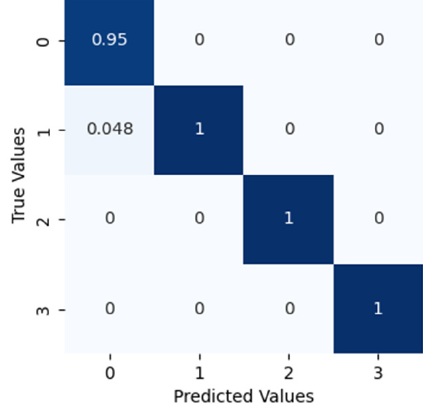
Figure 15. The confusion matrix for this classification.